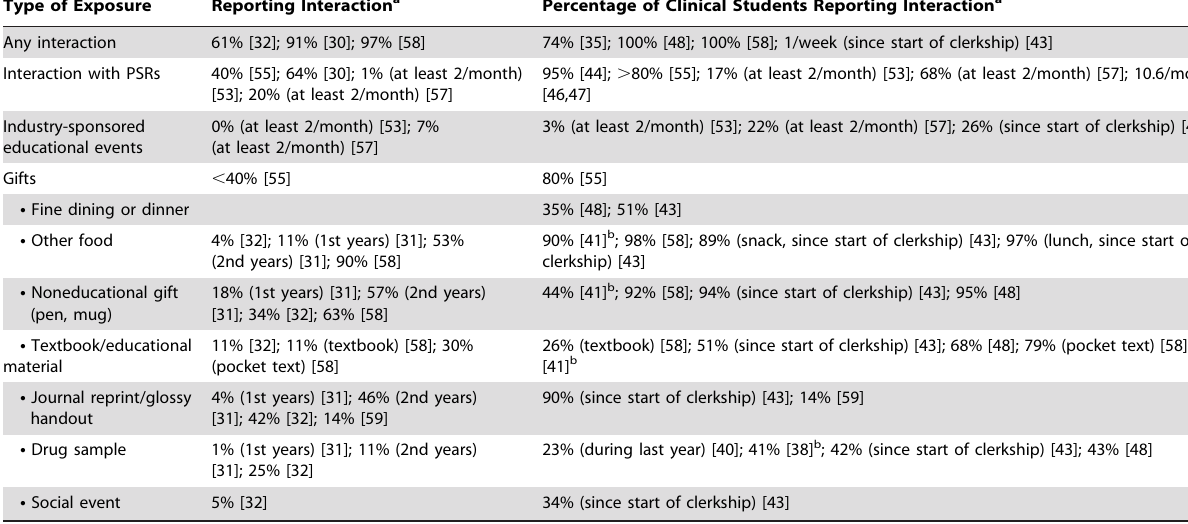
Percentage of Preclinical Students Type of Exposure Reporting Interaction a Percentage of Clinical Students Reporting Interaction